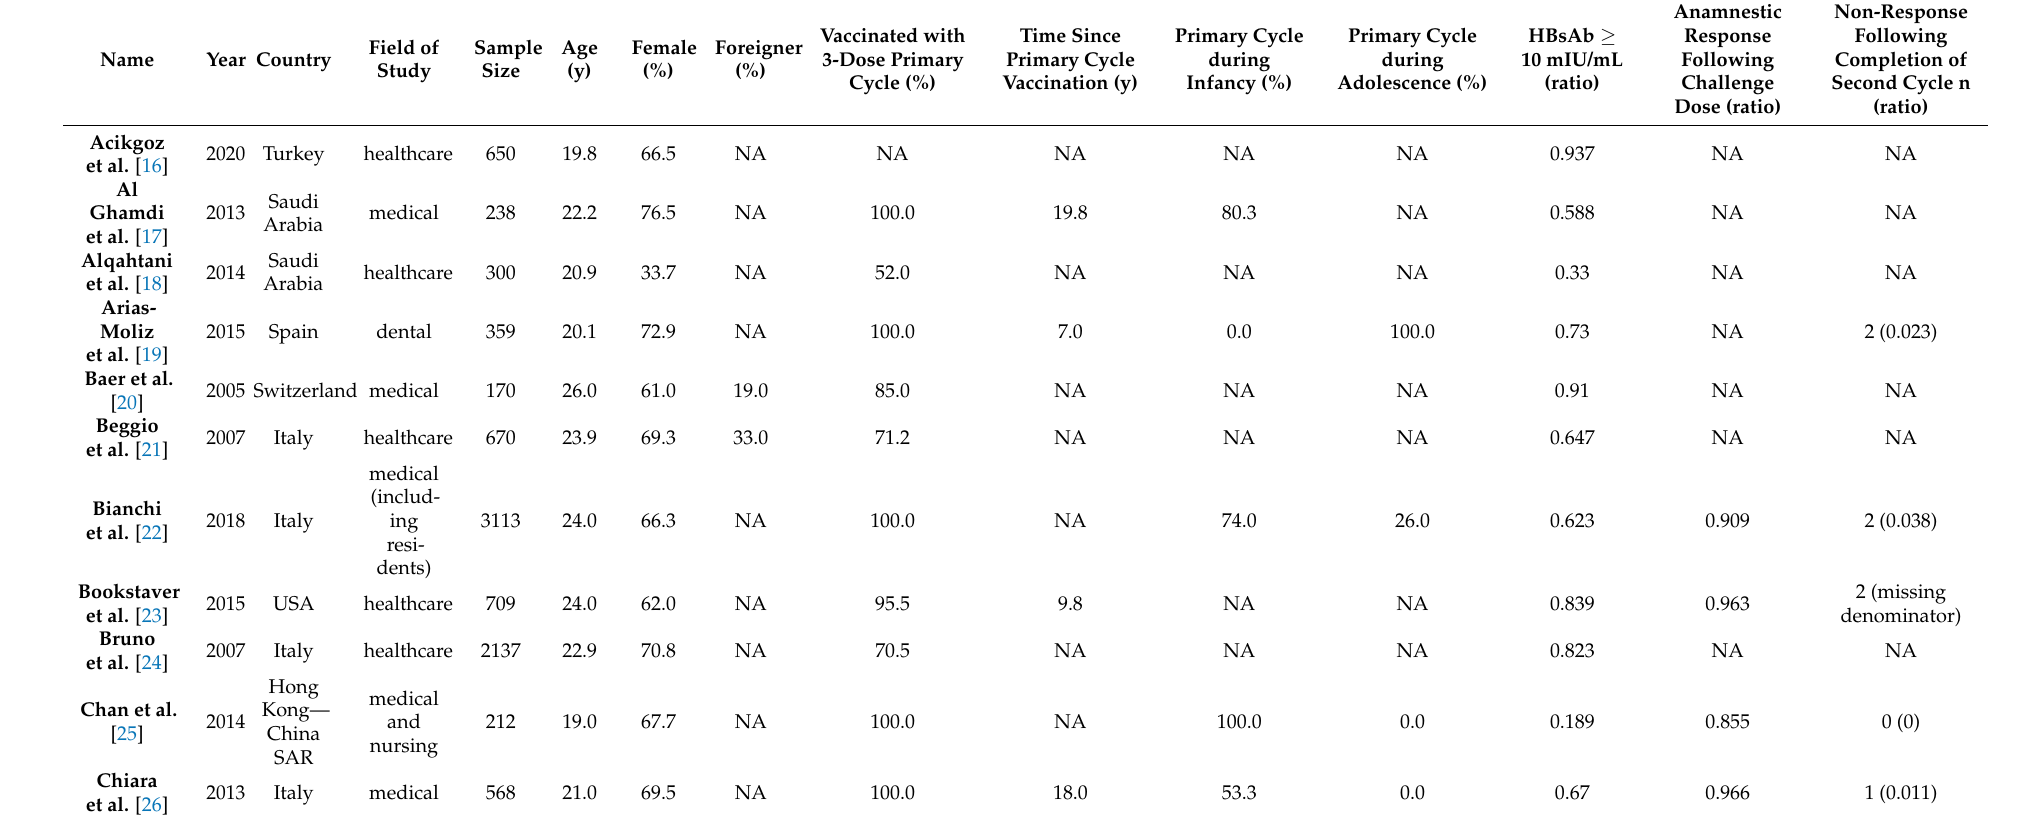
Table 1. Characteristics of the studies included in the current